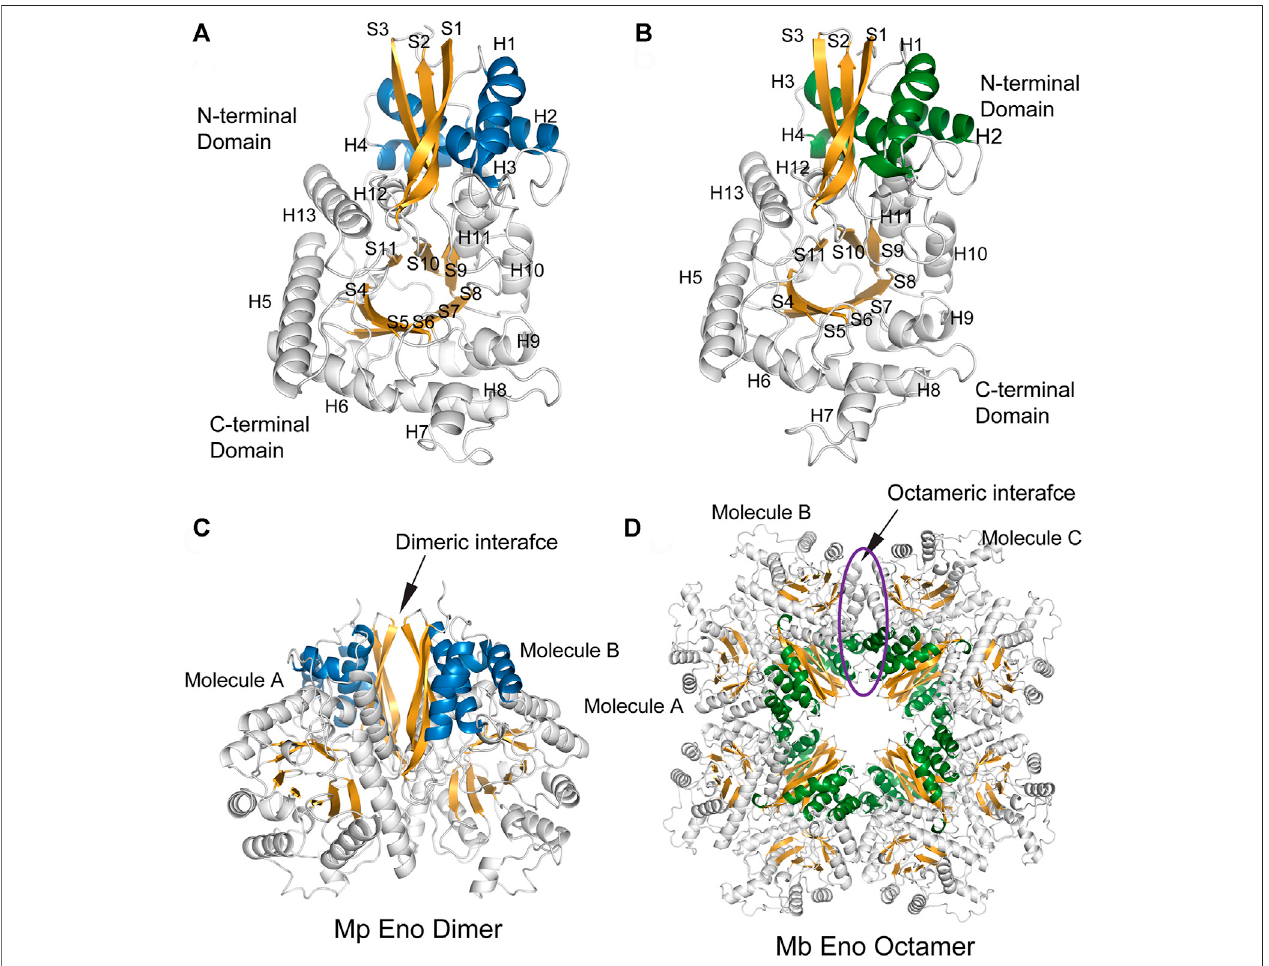
FIGURE 4 | The overall structures of Mp Eno and Mb Eno. (A,B) Structures of one molecule each of Mp Eno (A) and Mb Eno (B) . β -Strands and α -helices are sequentially numbered; “ S ” indicates a β -strand, and “ H ” indicates an α -helix. The β -strands are shown in orange. The α -helices of the N-terminal domains are shown in blue and green, in Mp Eno and Mb Eno, respectively. (C,D) Overall structures of Mp Eno (C) and Mb Eno (D) . (C) Mp Eno is a dimer. (D) Mb Eno is an